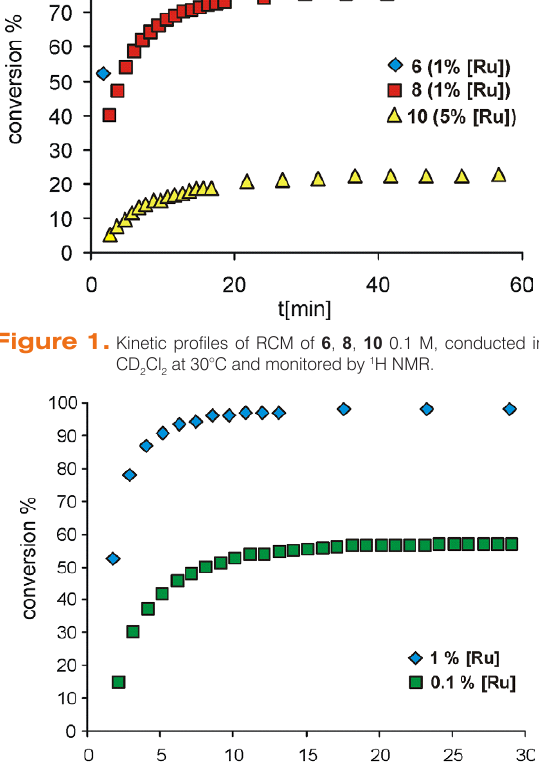
Figure 2. Kinetic profiles of RCM of 6 0.1 M, conducted in CD 30°C and monitored by 1 H NMR.